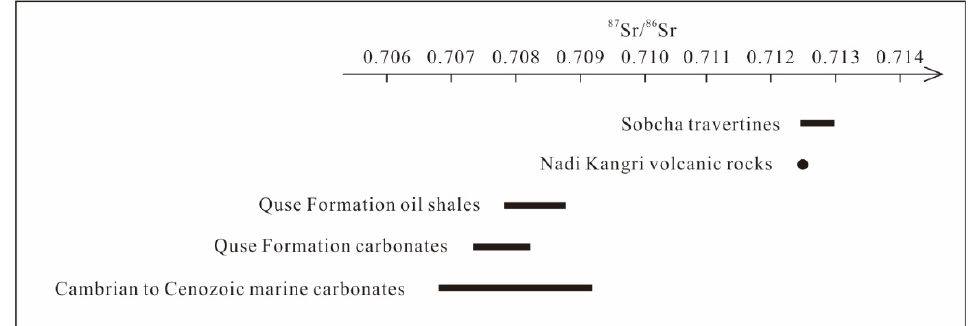
Figure 8. 87 Sr/ 86 Sr in the studied travertines in comparison with 87 Sr/ 86 Sr ranges of potential Sr source rocks: oil shales and micritic limestones of the Quse Formation (data from Fu et al. [76]), average values of Nadi Kangri volcanic rocks (data from Fu et al. [75]), and Cambrian to Cenozoic marine carbonates (data from McArthur et al. [77]).